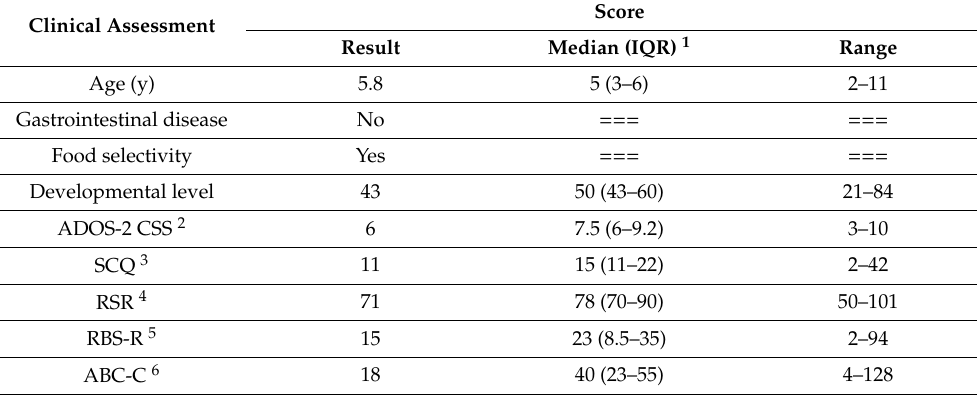
Table 2. Scores resulting from clinical assessments and behavioral scales tested for the ASD child #69. Median and IQR were computed from results obtained in 31 ASD children.